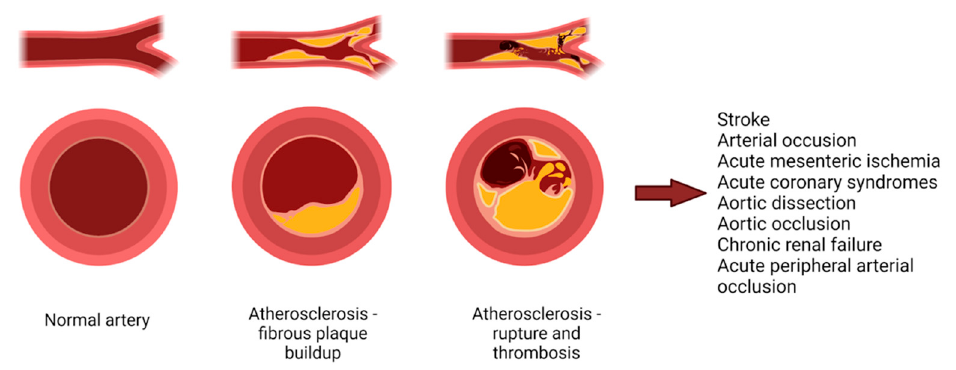
Figure 1. Evolution of atherosclerosis and its consequences. The process of atherosclerosis begins with an endothelial injury, leading to accumulation of macrophage foam cells and infiltration of smooth muscle cells with development of fatty streaks. From this point, atherosclerosis, through an inflammatory process, will lead to the development of a vulnerable plaque, consisting of necrotic core, micro- and macrocalcification, and intraplaque hemorrhage. When the thin fibrous cap of the vulnerable plaque develops a fissure, platelets will begin to aggregate, leading to thrombosis and acute coronary syndrome, but also other pathologies. Created with BioRender.com (Last accessed on 21 July 2021).